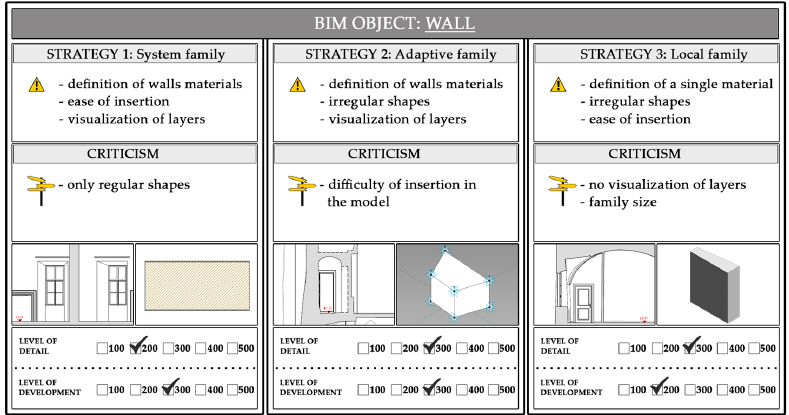
Figure 8. Different strategies adopted for wall Revit family.